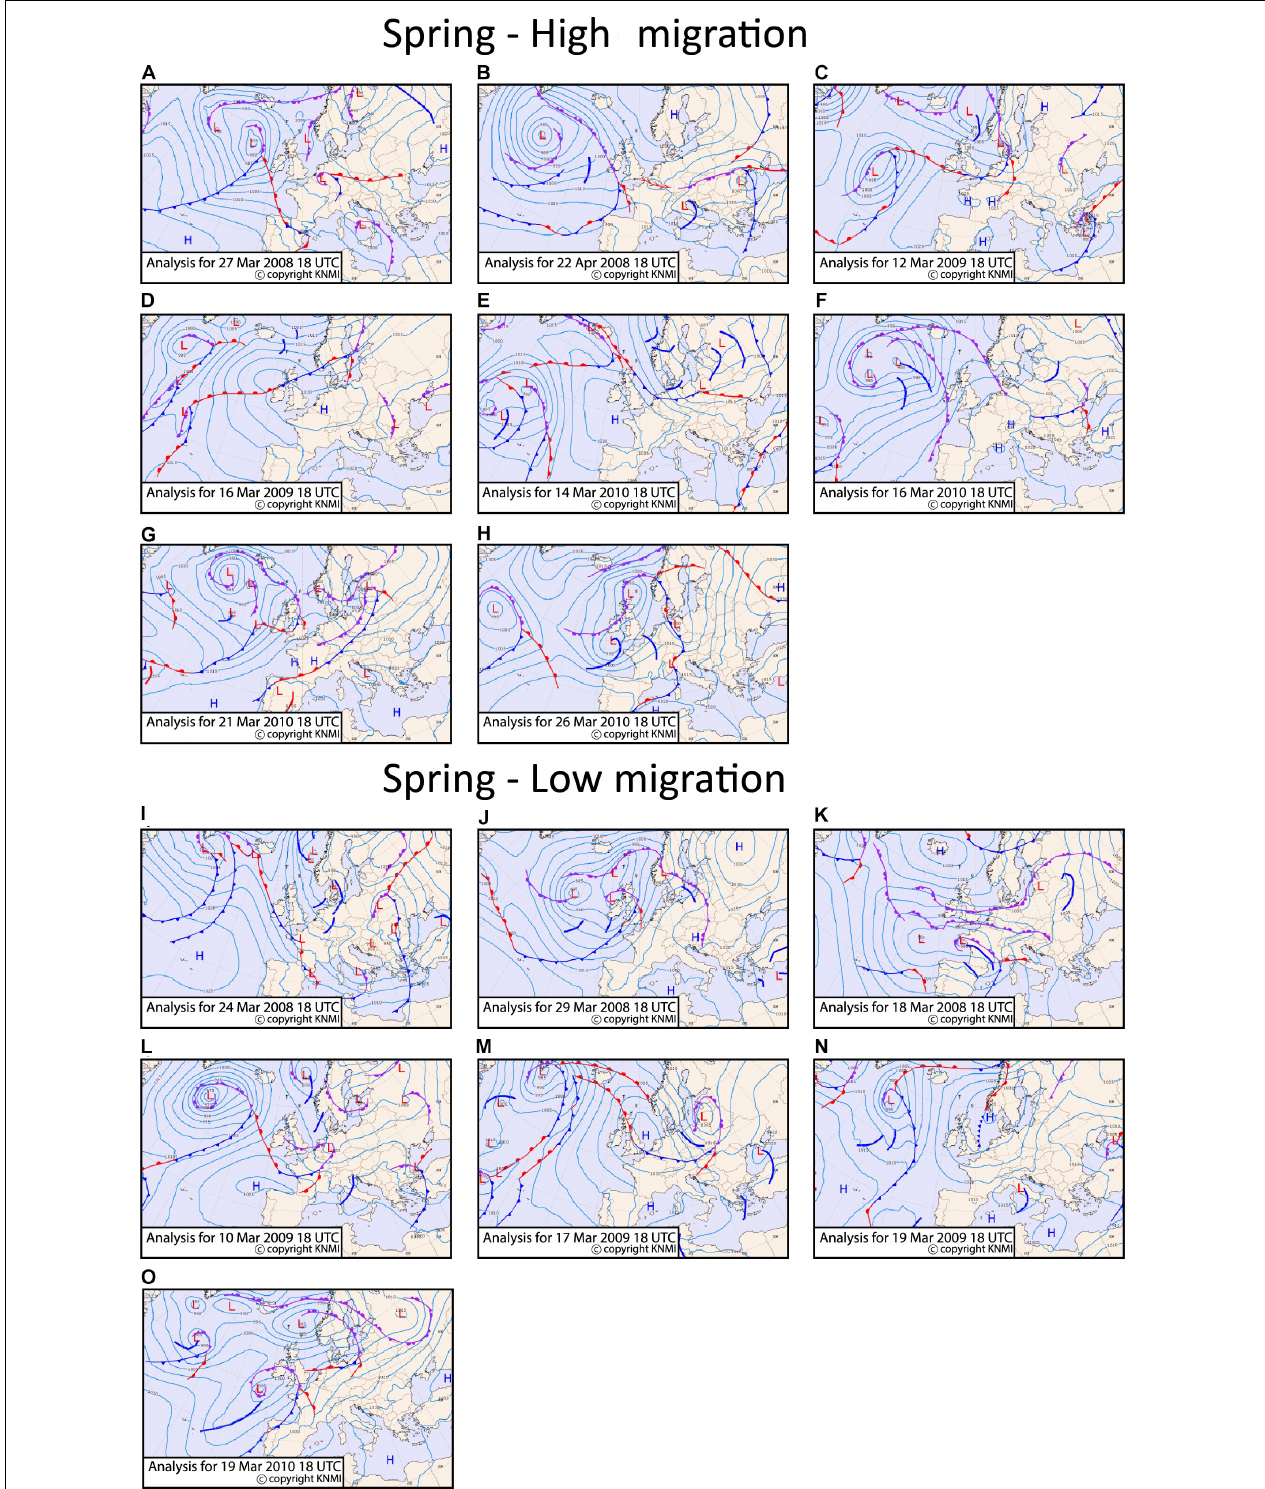
FIGURE 8 | Surface pressure and frontal systems for the high migration nights (A–H) and the low migration nights (I–O) for spring at 18:00 UTC. The figures are extracted from KNMI data center. The position of the core of a low pressure system is indicated with an “L” and of a high pressure system with an “H.” The cold fronts are indicated as lines in blue color, the warm fronts in red color and the occluded fronts in purple color. The side where the symbols are drawn on the front lines indicate the direction of the front’s movement. The thick blue lines indicate troughs.